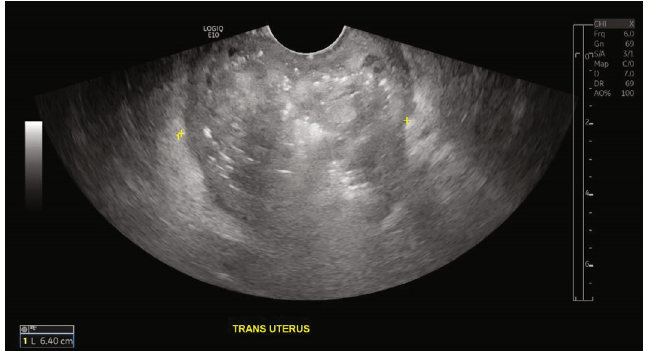
Figure 3: Transvaginal ultrasound performed in the emergency department. Foul-smelling discharge noted in addition to heterogeneous material and air within the uterus.